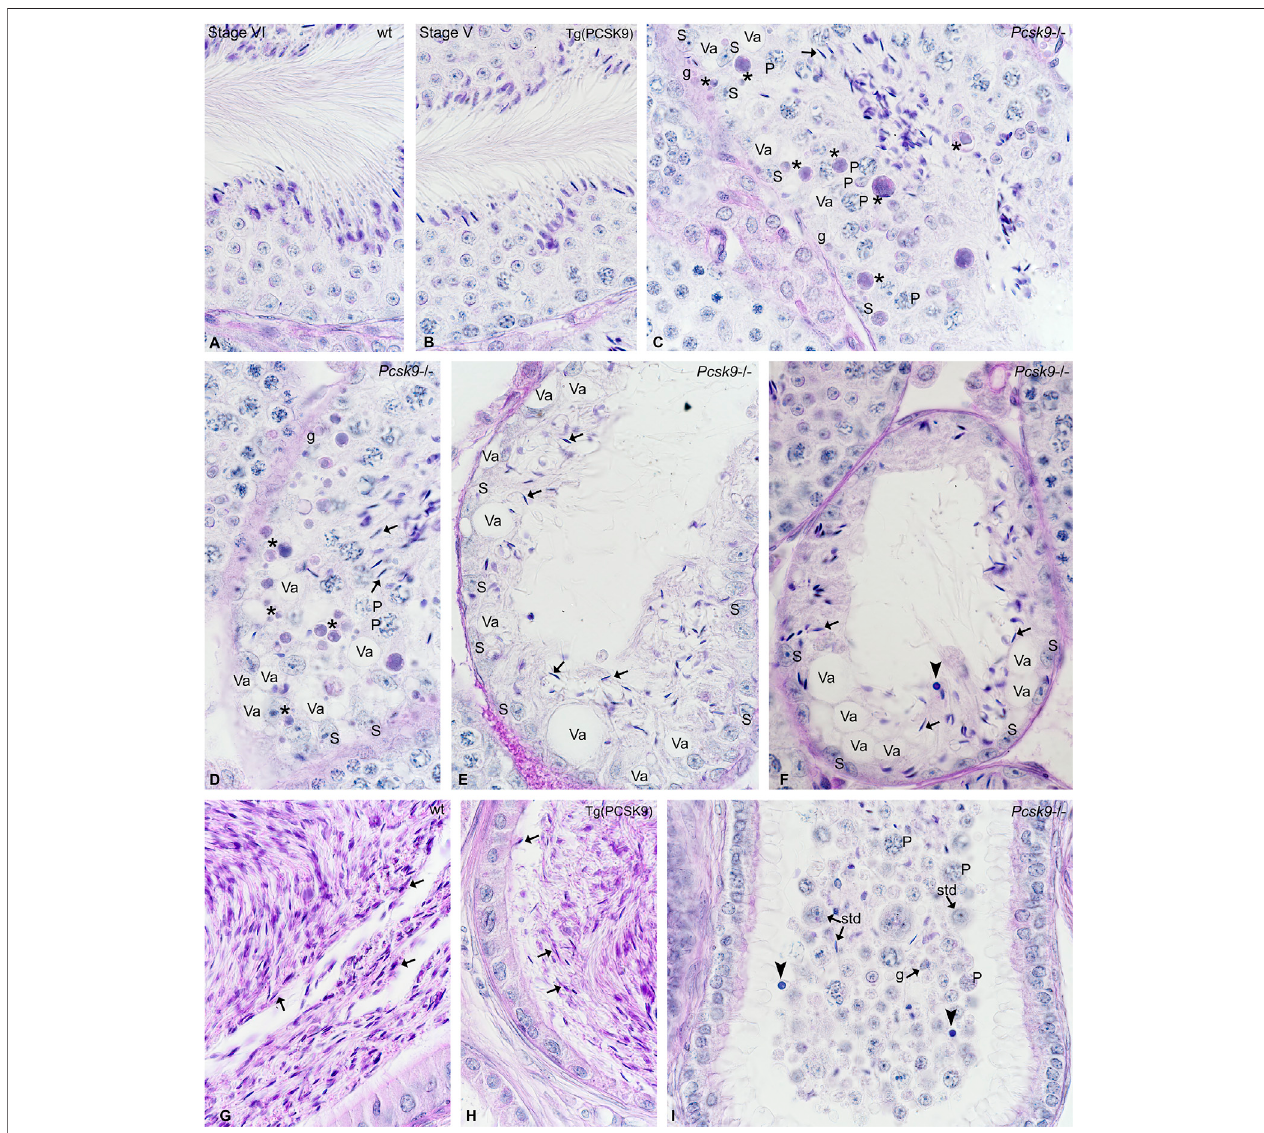
( Figure 3C , ITf). ACAT2 protein levels signi fi cantly increased in Pcsk9 − / − mice compared to WT, whereas Tg (PCSK9) and WT mice had comparable ACAT2 levels ( Figure 3C , ITf). In contrast, ACAT1 and HSL levels changed little in Pcsk9 − / − and Tg (PCSK9) compared to WT mice ( Figure 3C ,